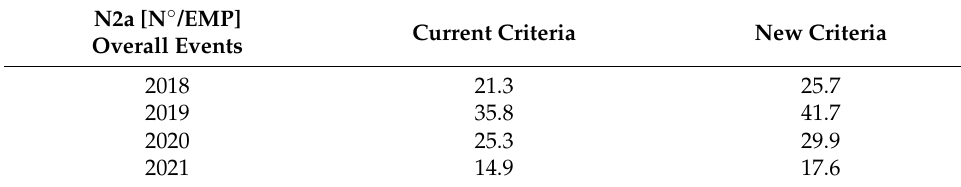
Table 8. N2a comparison: overall events.